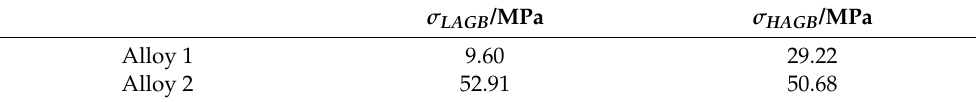
Table 5. Dislocation strengthening and grain-boundaries strengthening of as-extruded Al-5Mg